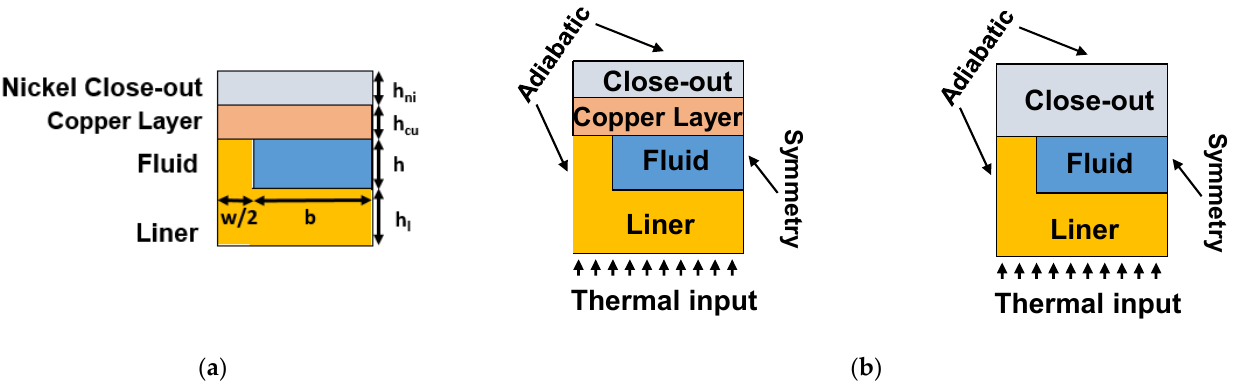
Figure 7. Sketch of the model concerning: ( a ) geometry description of the DEMO-0A cooling jacket—cross-section; ( b ) materials and boundary conditions for electroplated (left) and brazed (right) DEMO versions.